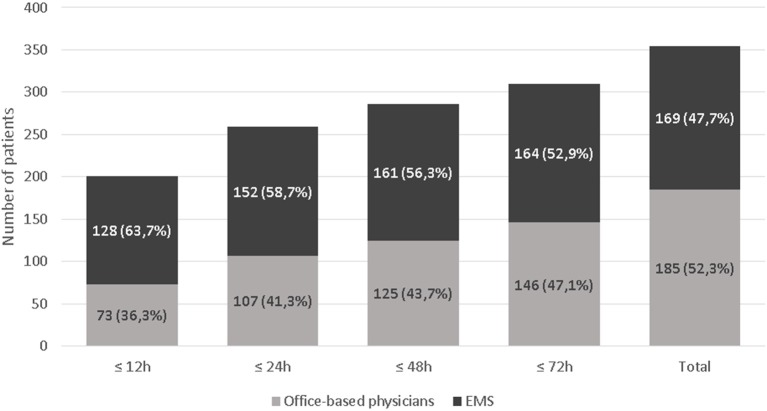
Proportion of patients evaluated within 12, 24, 48, and 72 h according to the type of medical referral.